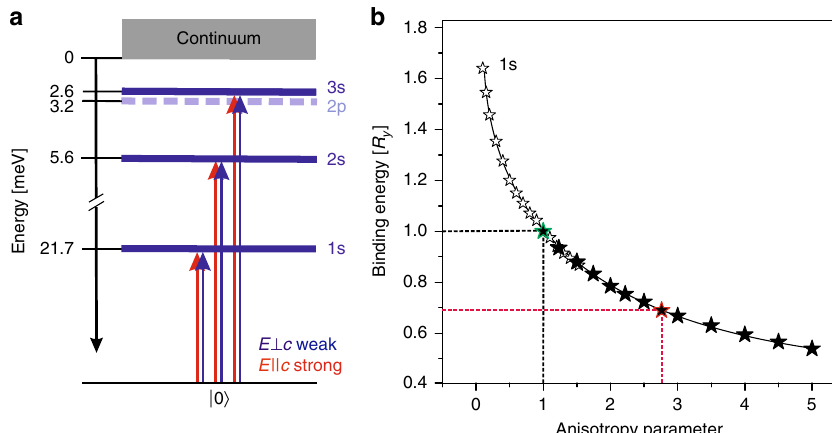
Fig. 5 Excitons in anisotropic InSe. a Schematic of the exciton levels in InSe, where the calculated binding energies are plotted from the ionization edge. b Calculated dependence of the 1 s exciton-binding energy vs. the parameter of anisotropy. Our data, marked by the full symbols, coincide well with the data reported in ref. 42 , marked by the empty symbols. The green and red lines indicate the ideal isotropic and realistic anisotropic InSe cases,